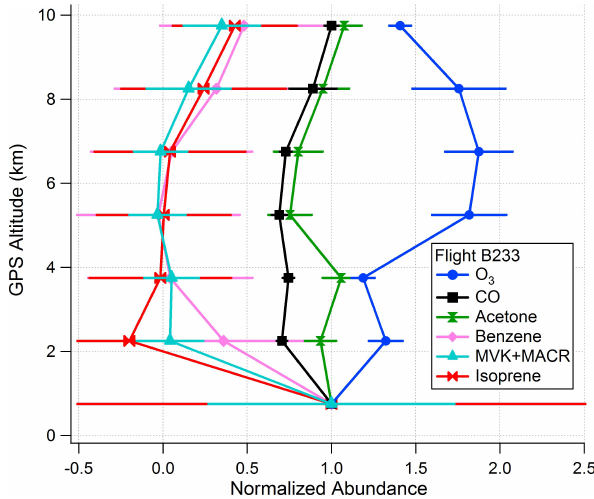
Fig. 4. Normalized altitude profiles of O 3 , CO, acetone, benzene, isoprene, and the sum of methyl vinyl ketone and methacrolein from Flight B233. The symbols represent the mean mixing ratio in an al- titude bin with a width of 1500m, normalized to the average mixing ratio in the lowest 1500m. The error bars represent the standard de- viation of the normalized amount.